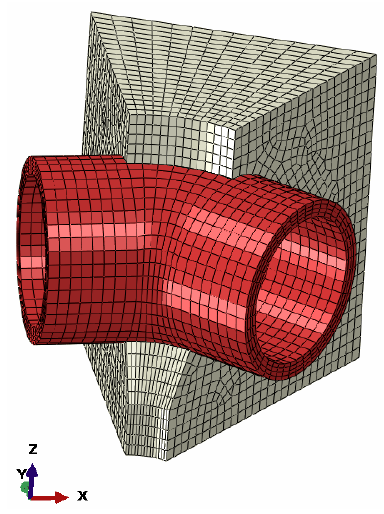
Figure 14. Discretization of the structural model.